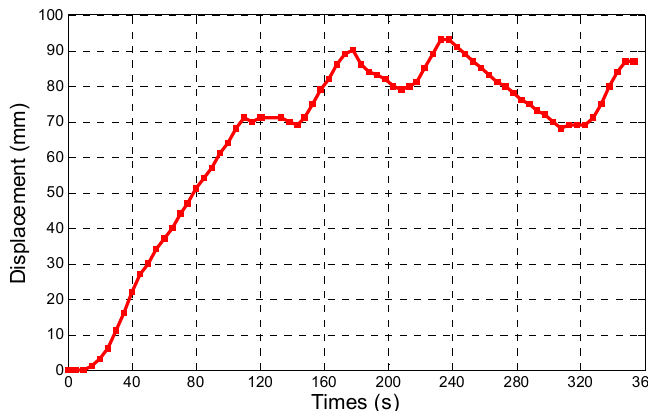
Figure 16. Multiple reciprocating motion.